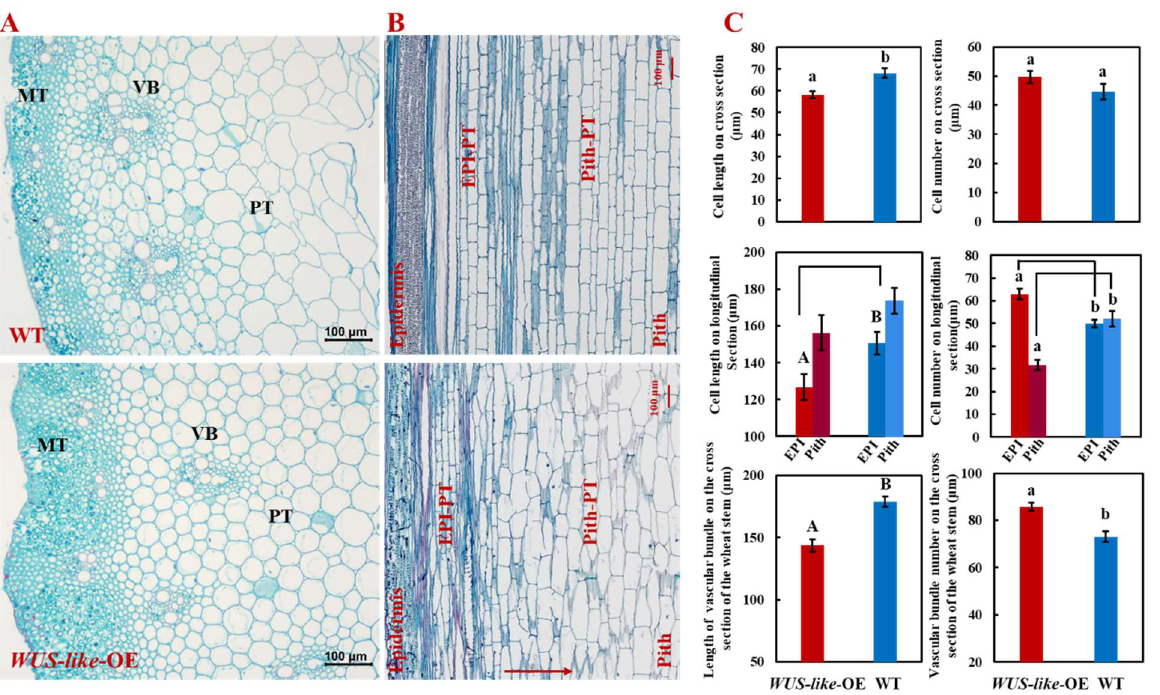
Figure 2. Morphology of the internode of TaWUS-like -OE lines and WT at heading stage. ( A ) Cross-section of the uppermost internode (MT: mechanical tissue; PT: parenchyma; VB: vascular bundle); ( B ) Longitudinal section of the uppermost internode (Epi: epidermis; Pith: pith; EPI-PT and Pith-PT indicate the parenchyma cell nearest to epidermis and mid medulla, respectively); ( C ) Data for cell number, size and vascular bundle tissues. Uppercase and lowercase letters indicate p < 0.01 and p < 0.05, respectively.